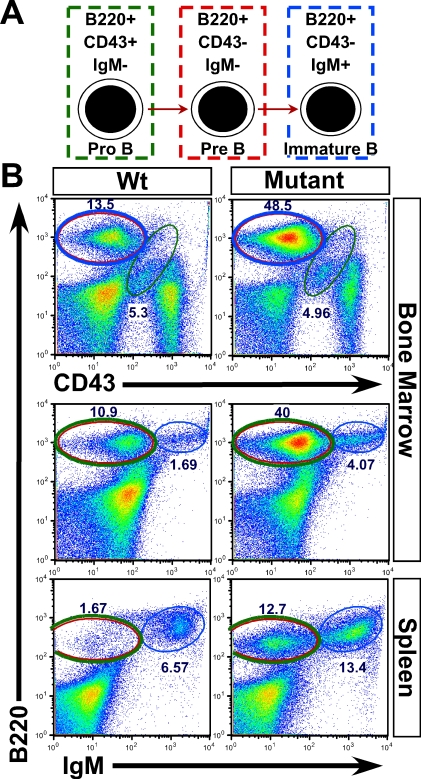
Expanding Pre- and Immature B Cells Cause B-LPD in the Mutant Animals(A) Schematic representation of how surface markers applied (B220, CD43, and IgM) identify pro-, pre-, and immature B cells.(B) FC analyses of BM and spleen cells demonstrate a clear expansion of pre- (red circle) and immature (blue circle) B cells in both central and peripheral compartments of the mutant animals. More than three mice from each genotype (PSDCKO, N1N2CKO, and wild-type littermates) are analyzed. Representative plots are shown.